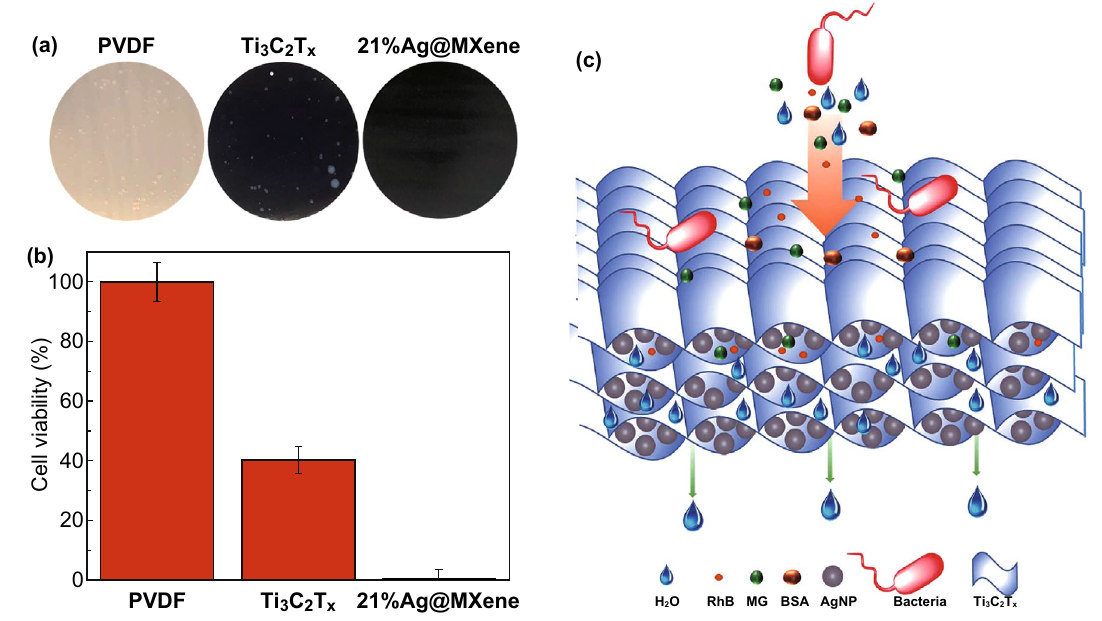
Fig. 4 Antibacterial activity of PVDF (control), MXene (Ti 3 C 2 T x ), and 21% Ag@MXene membranes: a photographs of E. coli cell growth incubated at 35 °C for 24 h. b Cell viability measurements of E. coli . c Schematic structure and mechanism of rejection of the 21% Ag@MXene composite membrane. Reprinted with permission from Ref. [51]. Copyright © (2019) Royal Society of Chemistry